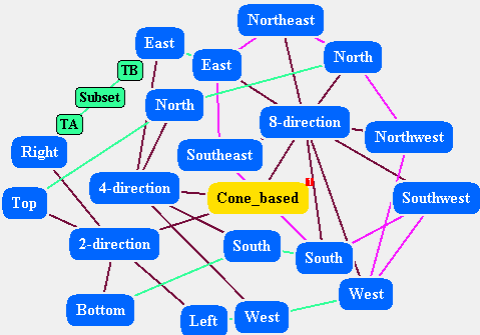
Figure 5. Topic map of neighborhood relations between direction tiles (3) As shown in Figure 6, Topic map of Cone-based direction relation model depicts the subset associations between the direction relations. The subset association is represented by green lines.